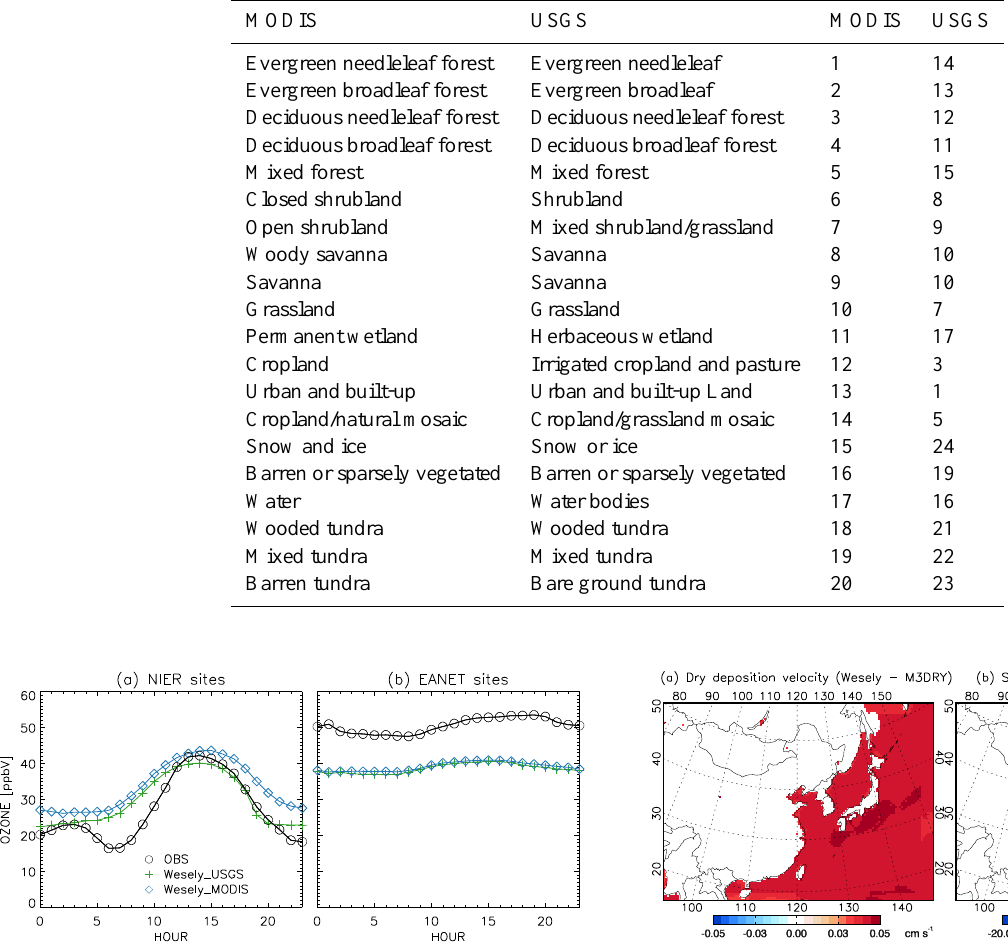
Figure 8. Differences in monthly mean O 3 dry deposition veloci- ties (left) and monthly mean O 3 concentrations in surface air (right) between the default and sensitivity simulations. The sensitivity sim- ulation was conducted using the Wesely scheme and replacing the ocean surface resistance with the values from the M3DRY scheme for May 2004.